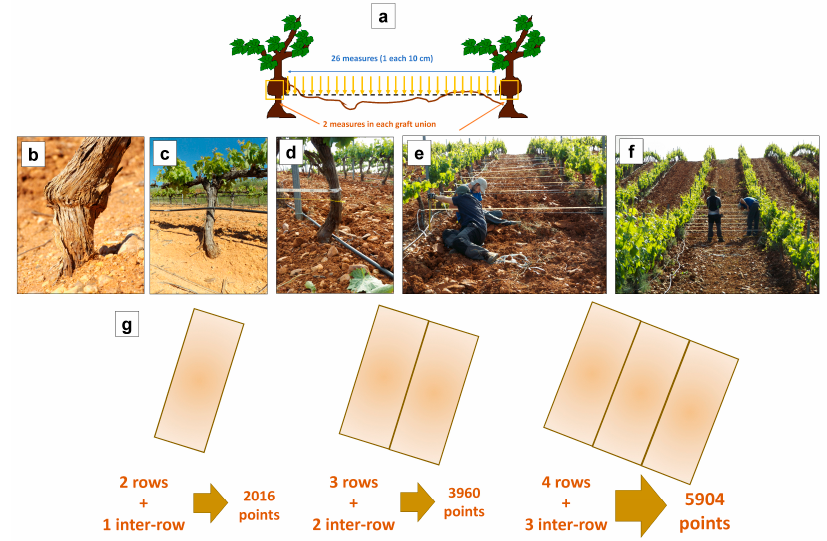
Figure 2. Flow chart including the Improved Stock Unearthing Method (ISUM) procedure. a : sampling point strategy for each inter-row transect; b : graft union; c: wheel tractor pass; d-f : applying